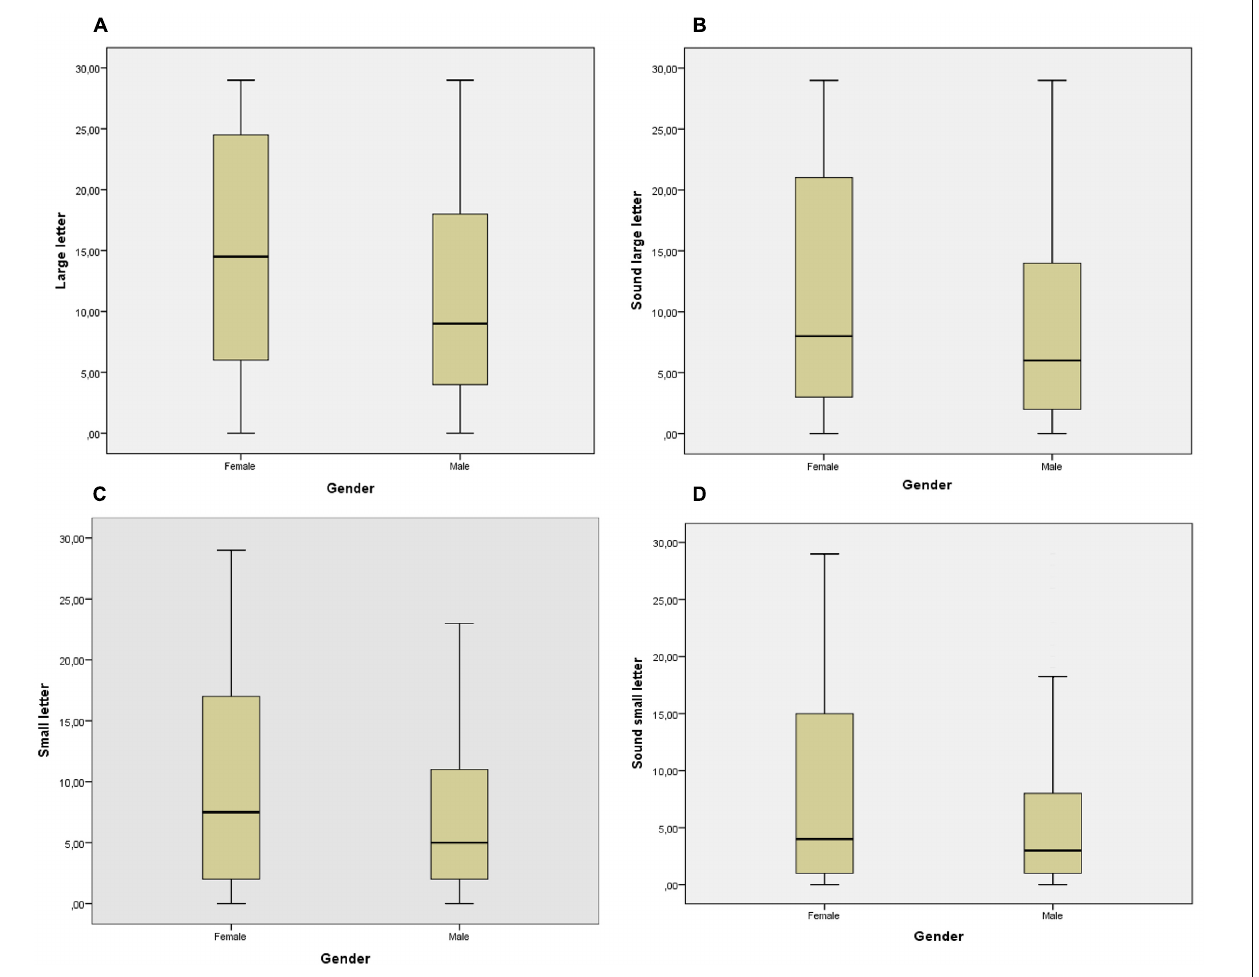
FIGURE 1 | Box plots depicting the female and male performance on letter-sound knowledge test. (A) Large letter; (B) sound large letter; (C) small letter; (D) sound small letters. Horizontal lines within boxes represent the group medians. Box edges define the first and third quartiles, whiskers define the 10 and